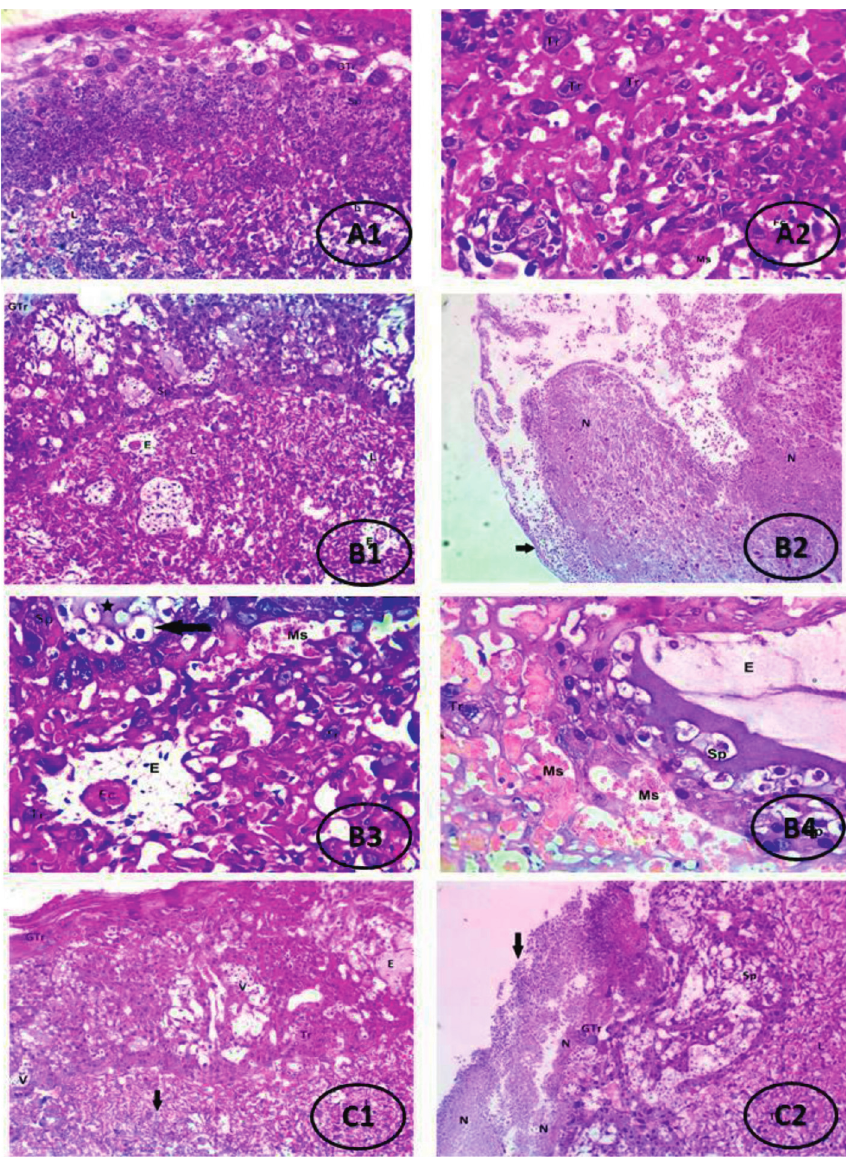
Figure 15: Photomicrographs of placenta of control and different treated groups. (A1, A2) Photomicrograph of placenta of the normal pregnant group showing normal placental histology. Giant trophoblasts (GTr) and spongioblasts (Sp) showing normal labyrinth histology. Tr, trophoblasts, Fc, fetal capillaries, Ms, maternal sinuses (Ms), and L, labyrinth (H&E, X100). (B1–B4) Photomicrograph of placenta of the PE group showing edema (E) and fluid accumulation in the interstitial space between spongioblasts. GTr, giant trophoblasts, Sp, spongioblasts, L, labyrinth, and N, wide areas of necrosis, including the whole placenta leaving only ghosts of cells with infiltration of inflammatory cells (black arrow) (H&E, X100), and edema (E) in the interstitial space between spongioblasts (asterisk) with hydropic degeneration in some spongioblasts (black arrow). In the labyrinth, foci of villous edema surrounding the fetal capillaries are seen. Fetal capillaries show thrombus formation. Tr, trophoblasts, Fc, fetal capillaries, Ms, maternal sinuses, Sp, spongioblasts (H&E, X400). (C1, C2) Photomicrograph of placenta of the apelin-treated PE group showing mild placental changes including degenerative changes in some giant trophoblastic cells, vacuolar degeneration in some spongiotrophoblast (V), and mild inflammatory reaction (black arrow) in the labyrinth (L) (H&E,